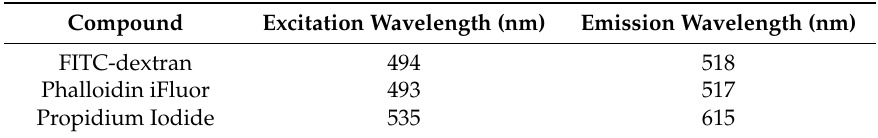
Table 2. Excitation and emission wavelengths of the dyes and transport marker used in the confocal imaging experiments